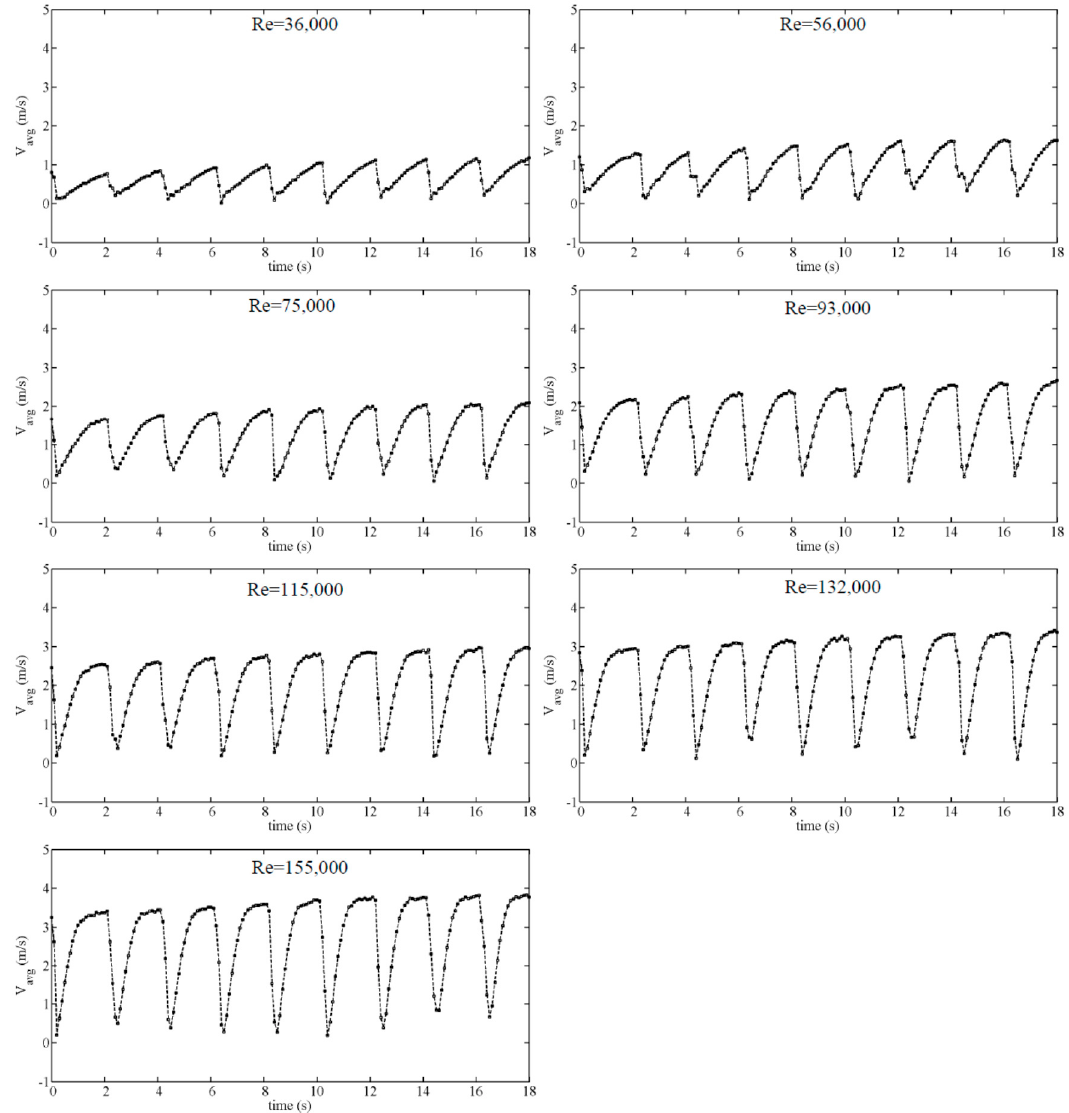
Figure 11. Average velocity for different Re during 9WH tests.